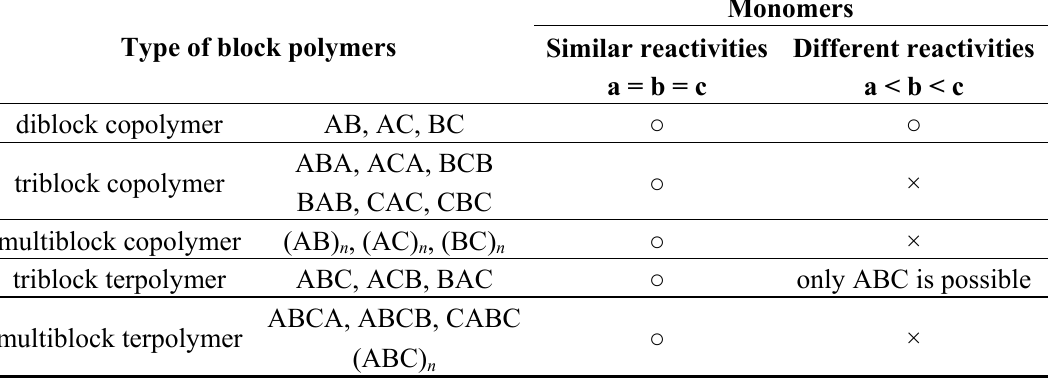
Monomers Similar reactivities Different reactivities a = b = c